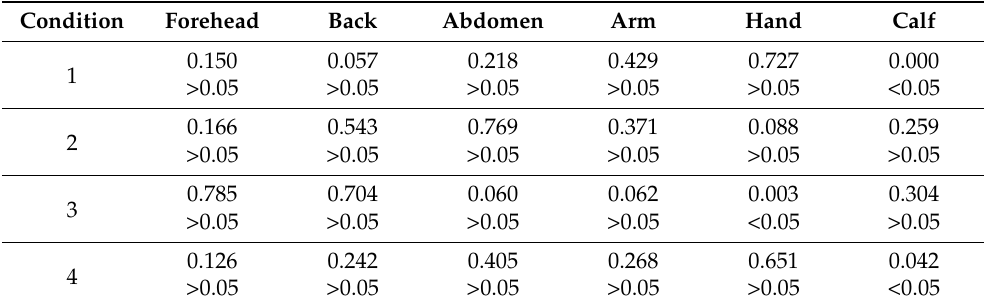
Table 4. Paired t -test significance (two-tailed) values of local skin temperatures in preschool children and young adults.